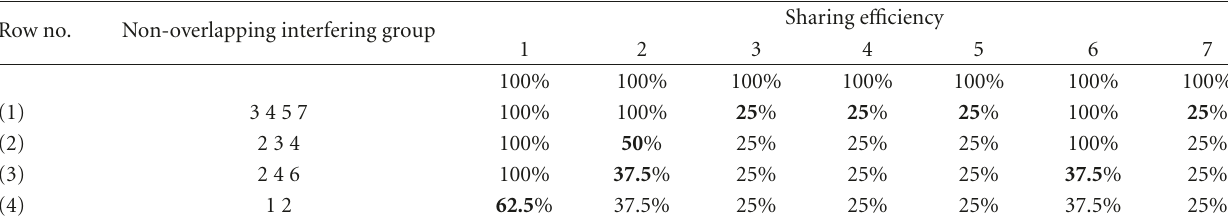
Table 1: Optimal sharing e ffi ciency